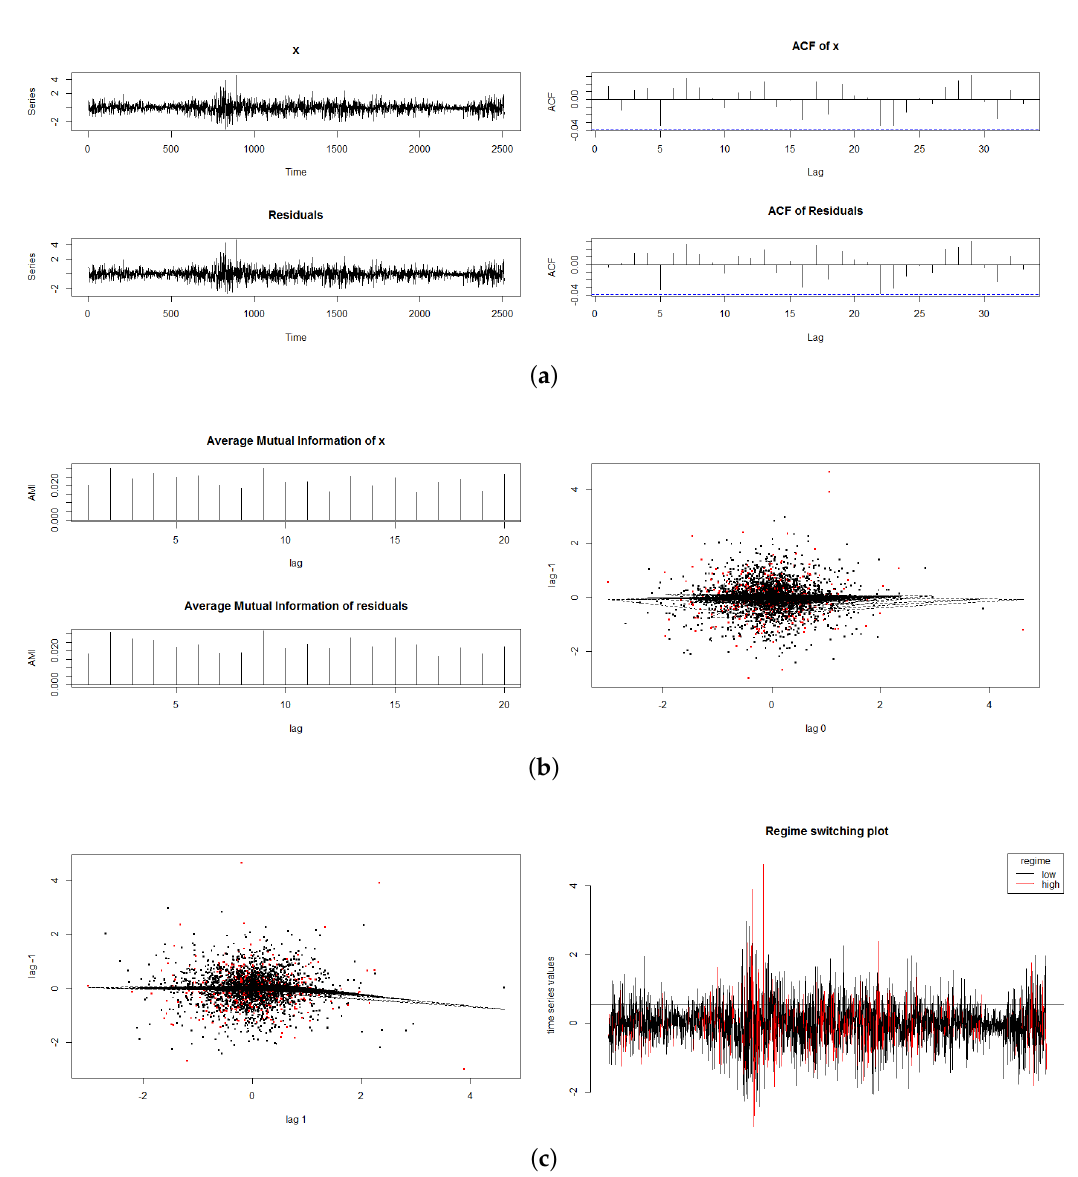
Figure 3. SETAR analysis of US$ - Euro returns; ( a ) Euro SETAR Residuals and ACF; ( b ) MI Euro and lag − 1, 0; ( c ) lag 1 − 1 SETAR Euro and Regime